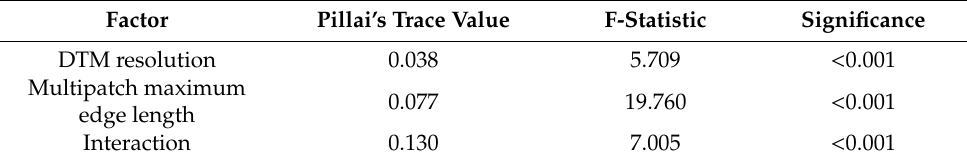
Table 5. Results of the two-way repeated measures ANOVA test.